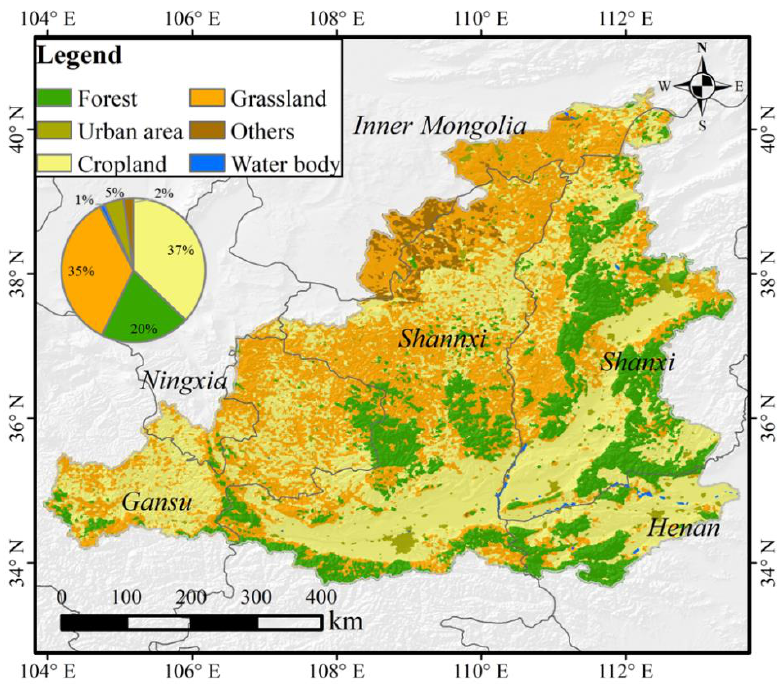
Figure 1. The location of the middle reaches of the Yellow River basin, China. The background colors indicate the different vegetation types in the region.